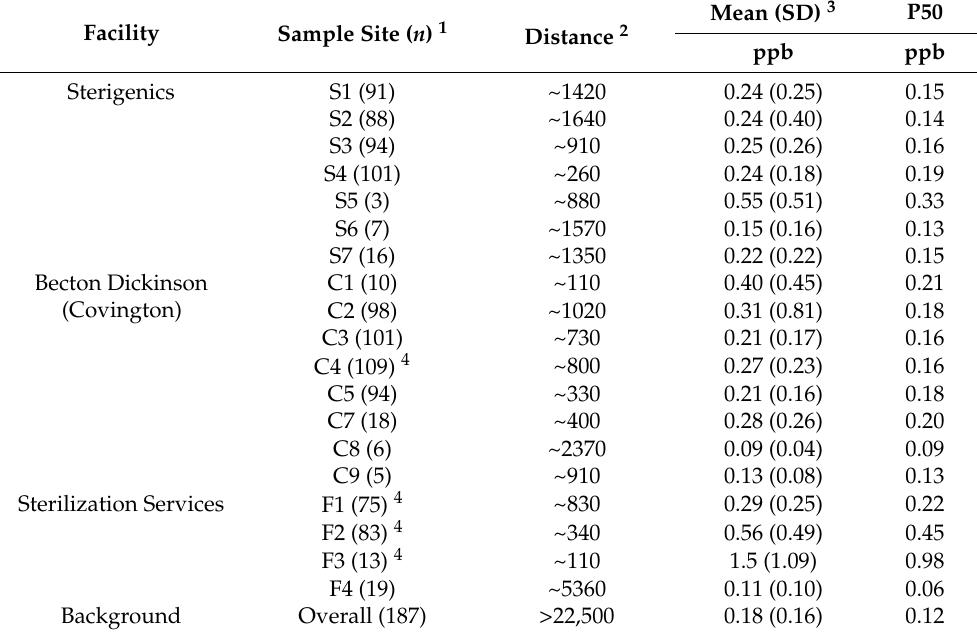
Table 4. Measures of central tendency and spread for ambient air EO concentrations in Georgia in the vicinity of three sterilization facilities and at background locations.